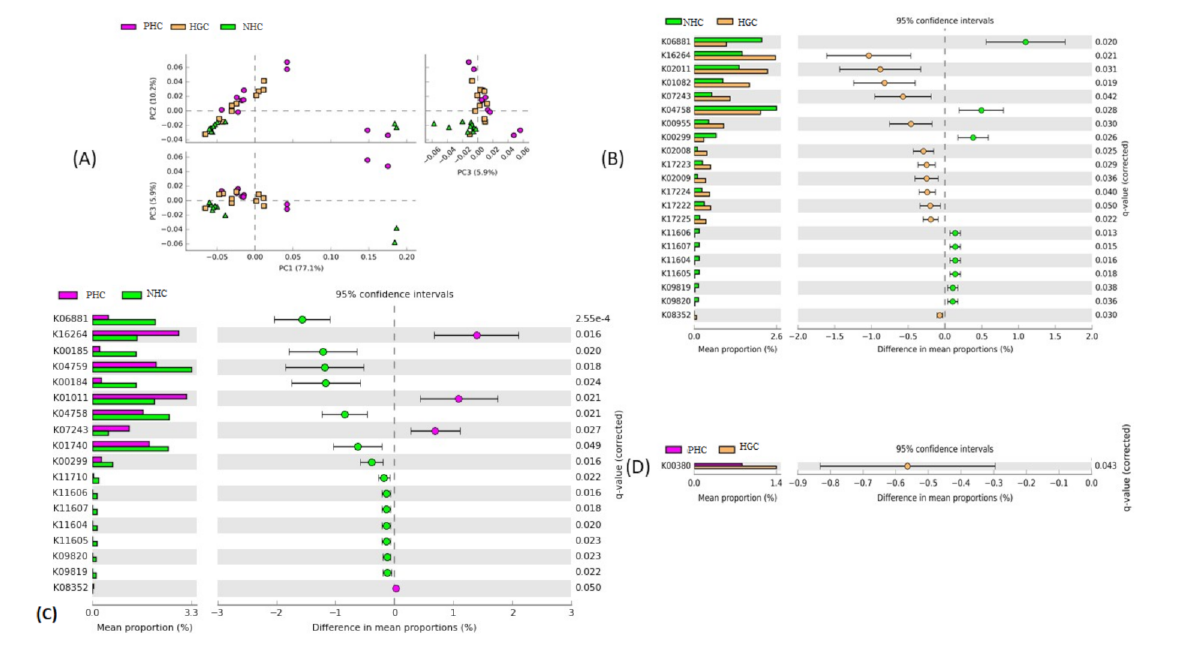
Figure 7. Functional prediction of the bacterial communities. ( A ) PCA showing the grouping of samples based on their predicted metabolic functions; significantly enriched bacterial functions among the ( B ) NHC and HGC, ( C ) PHC and NHC, and ( D ) PHC and HGC. Additionally, the Welch t -test, following FDR ( p < 0.05), was used to analyze the shifts in the predicted functional potentials of the bacterial communities to know the statistical sig- nificance among the experimental groups (Figure 7B–D). The analysis revealed that 21 pre- dicted functions were significantly enriched in the NHC and HGC samples (Figure